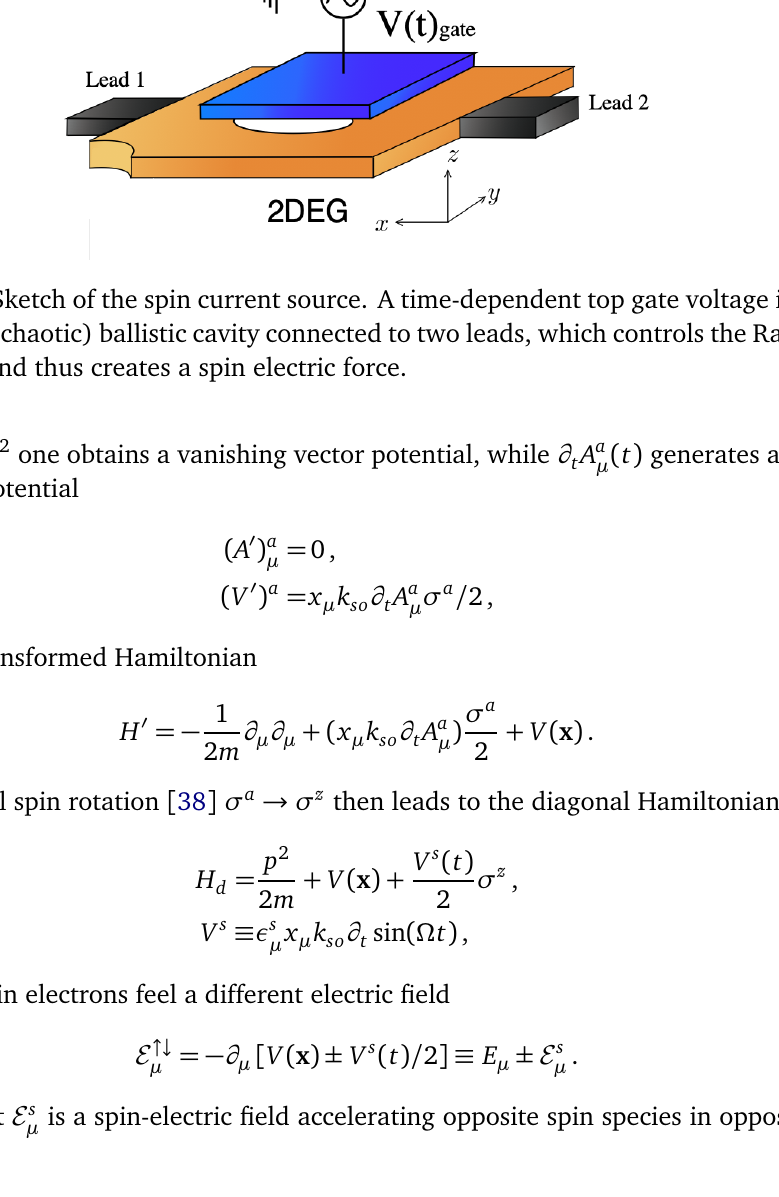
Fig. 1. This interconversion is achieved by the spin-dependent Lorentz force due to a